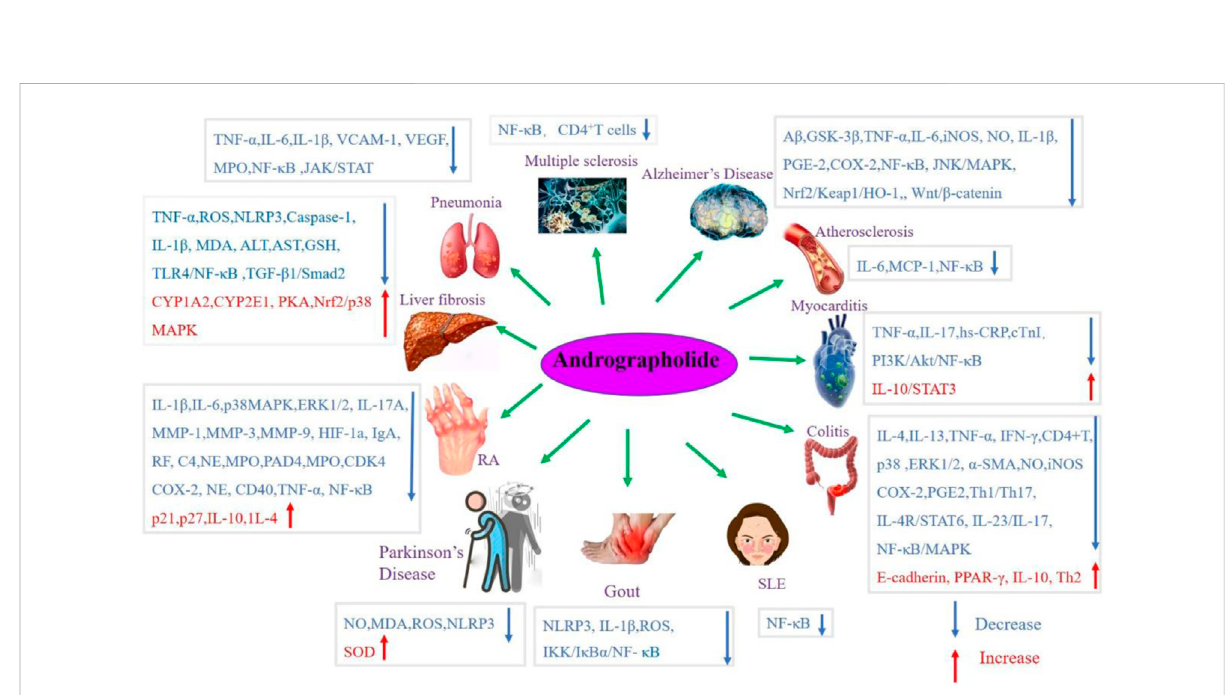
FIGURE 4 Andrographolide was used to treat in fl ammatory